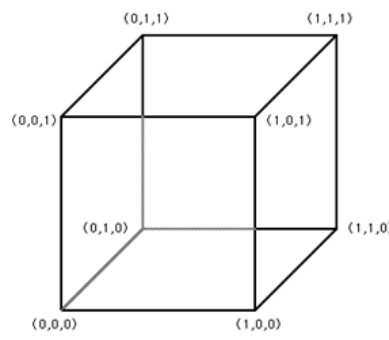
Figure 9. The vertices of cubes used for creating the histogram pyramids index.